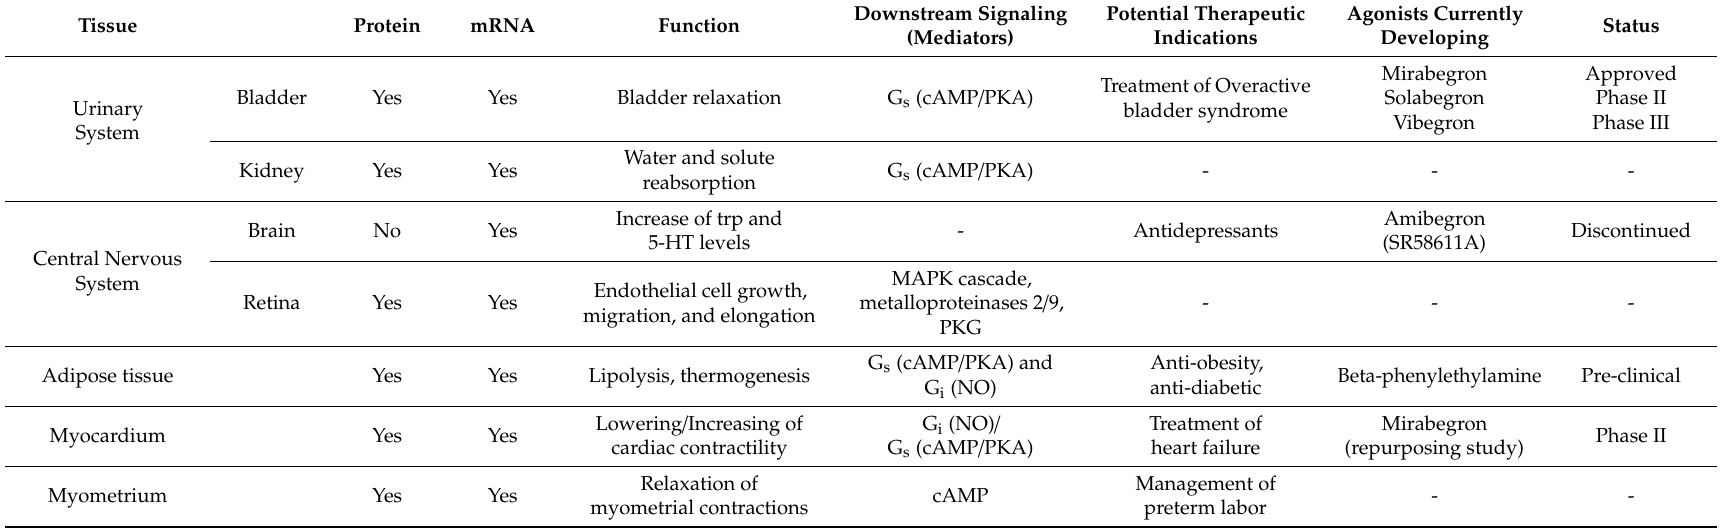
Table 2. Main tissues of β 3 -AR expression with relative downstream signaling and current uses in clinical